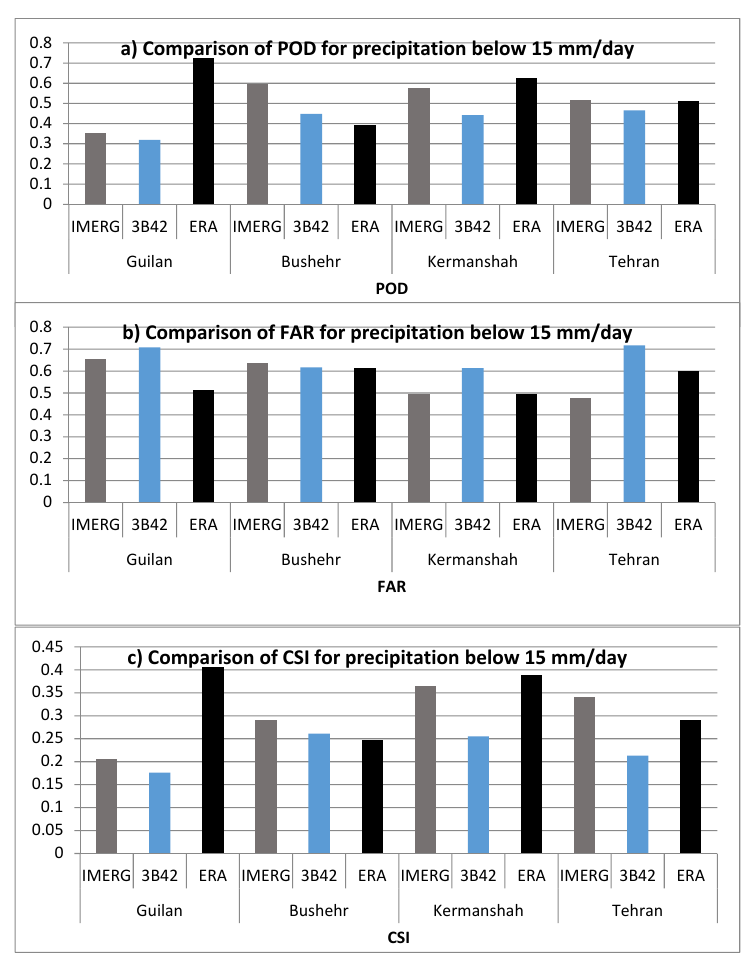
Figure 17. ( a – c ) POD, FAR and CSI in four study region for precipitation below 15 mm/day. Table 17. Spatially averaged POD, FAR and CSI metrics for precipitation below 15 mm/day. POD FAR CSI